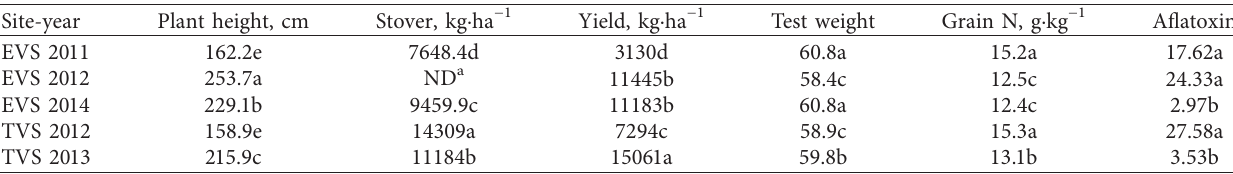
Table 4: Overall averages for plant height, stover yield, corn yield, test weight, grain N concentration, and aflatoxin content at five site-years during the 2011 to 2014 growing seasons across northern and central